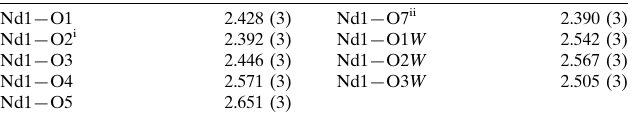
Key indicators: single-crystal X-ray study; T = 273 K; mean (cid:1) (C–C) = 0.006 A˚; R factor = 0.029; wR factor = 0.077; data-to-parameter ratio = 12.2.